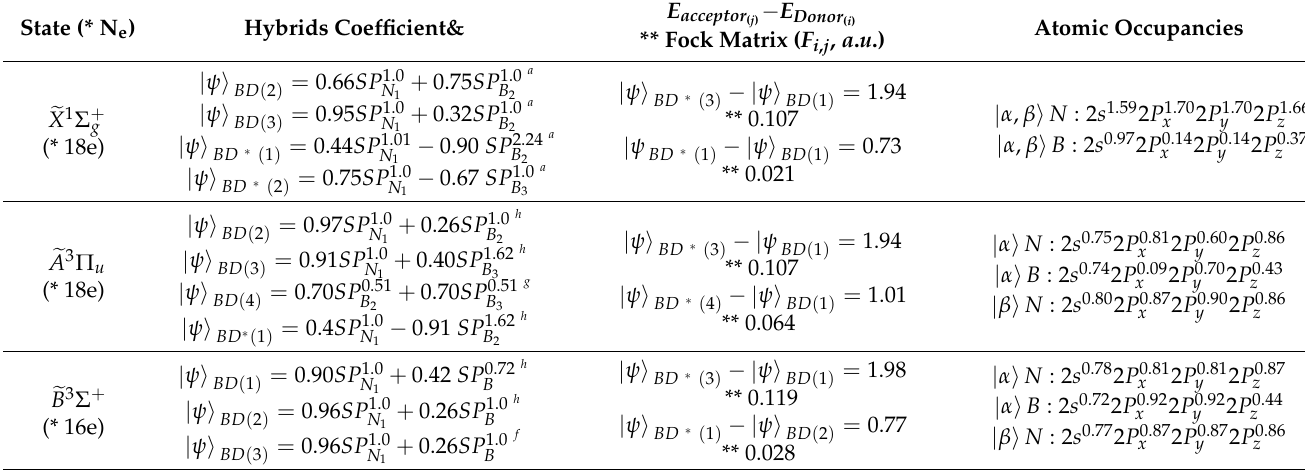
Table 4. The NBO, electric potential, anisotropic spin dipole couplings (ASDF), isotropic Fermi contact coupling { IFCC [ f ( ∆ )] , IFCC [ f ( θ )] }, atomic occupancies and Fock Matrix data of isolated and non-isolated forms of B 2 N ( − ,0, +) in ground and excited states.